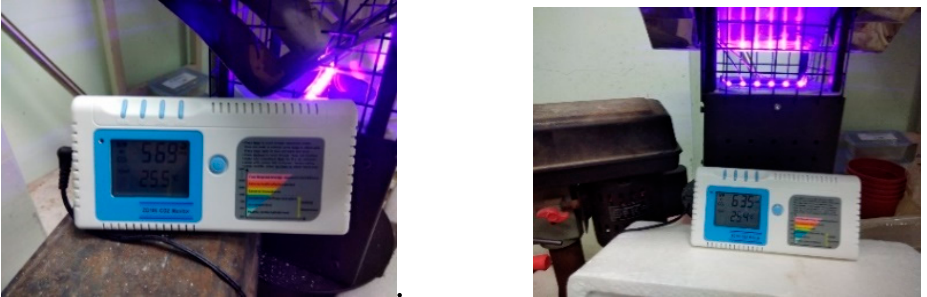
. . Figure 13. Detection and recording of CO 2 Figure 13. Detection and recording of CO 2 concentration. Figure 13. Detection and recording of CO 2 concentration.